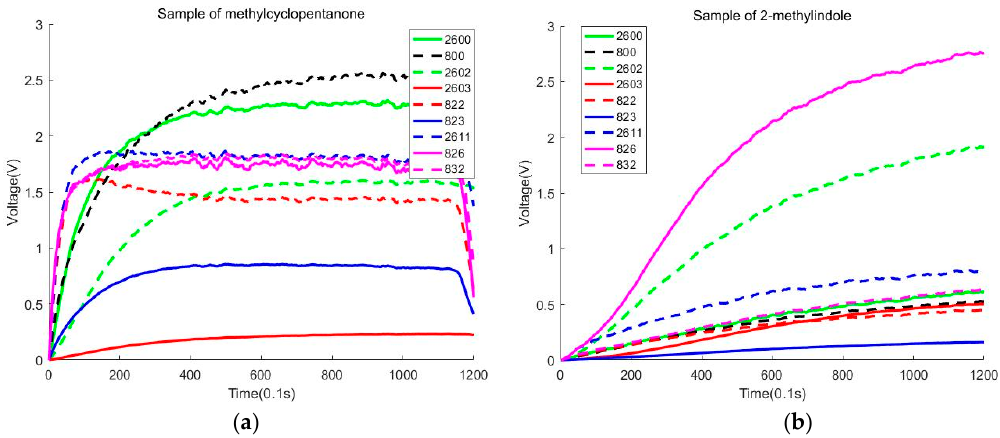
Figure 4. (a) Sample of methylcyclopentanone. (b) Sample of 2-methylindole. Figure 4. ( a ) Sample of methylcyclopentanone. ( b ) Sample of